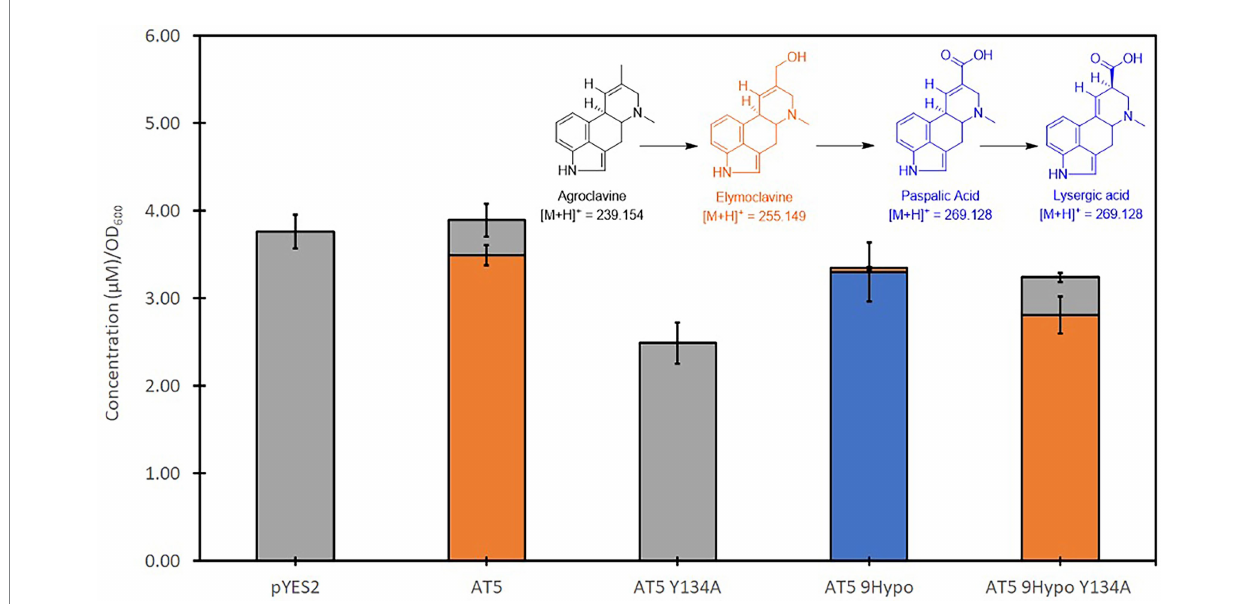
FIGURE 6 Screening of AT5 and AT5 9Hypo CloA Y134A mutants in the presence of agroclavine. Blue bars represent the mean concentration of lysergic acid while orange bars represent the mean concentration of elymoclavine produced by AT5 9Hypo CloA phenylalanine gate mutants. Error bars are representative of three biological replicates.